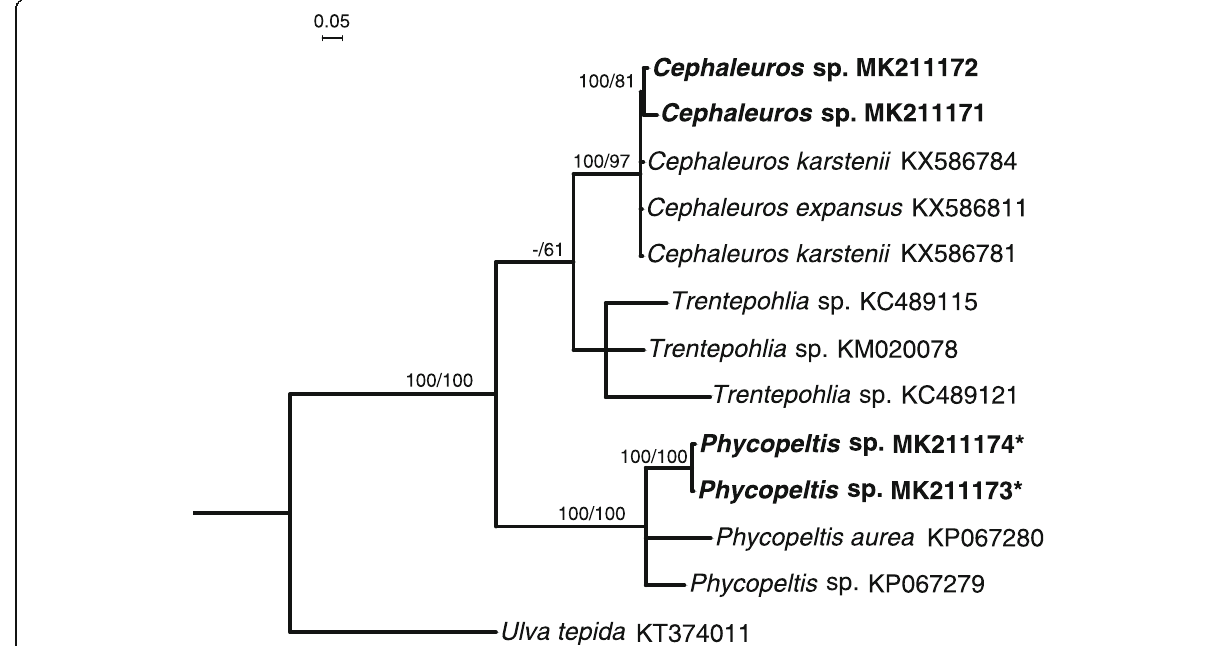
Fig. 4 Phylogenetic tree constructed from Bayesian analyses based on ITS of photobionts of Trentepohliaceae . Bayesian posterior probabilities (B – PP) > 90%, and Maximum likelihood bootstrap proportions >50% are shown at nodes (B – PP / ML – BP). The new sequences generated in this study are in bold, and algal partners from Tenuitholiascus porinoides are marked with